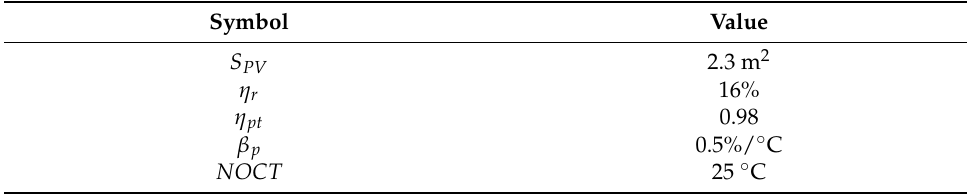
Table 2. Parameters of the photovoltaic system.